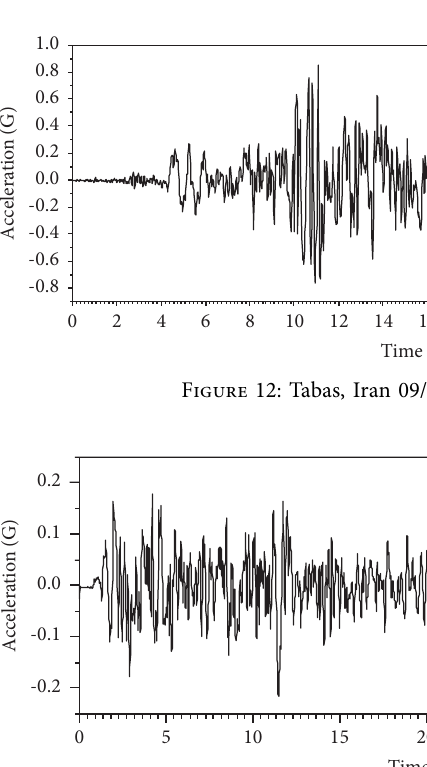
Figure 13: EI centro 270 seismic wave.